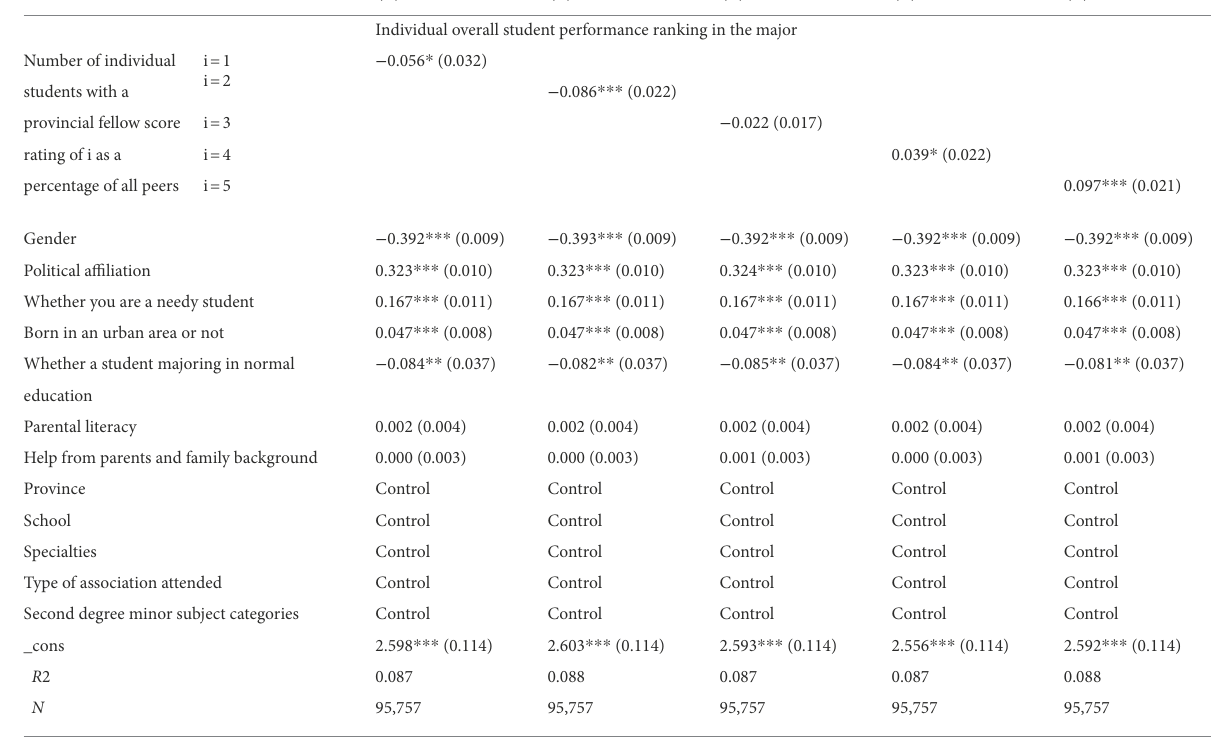
TABLE 10 Regression results after adjusting for mean values.